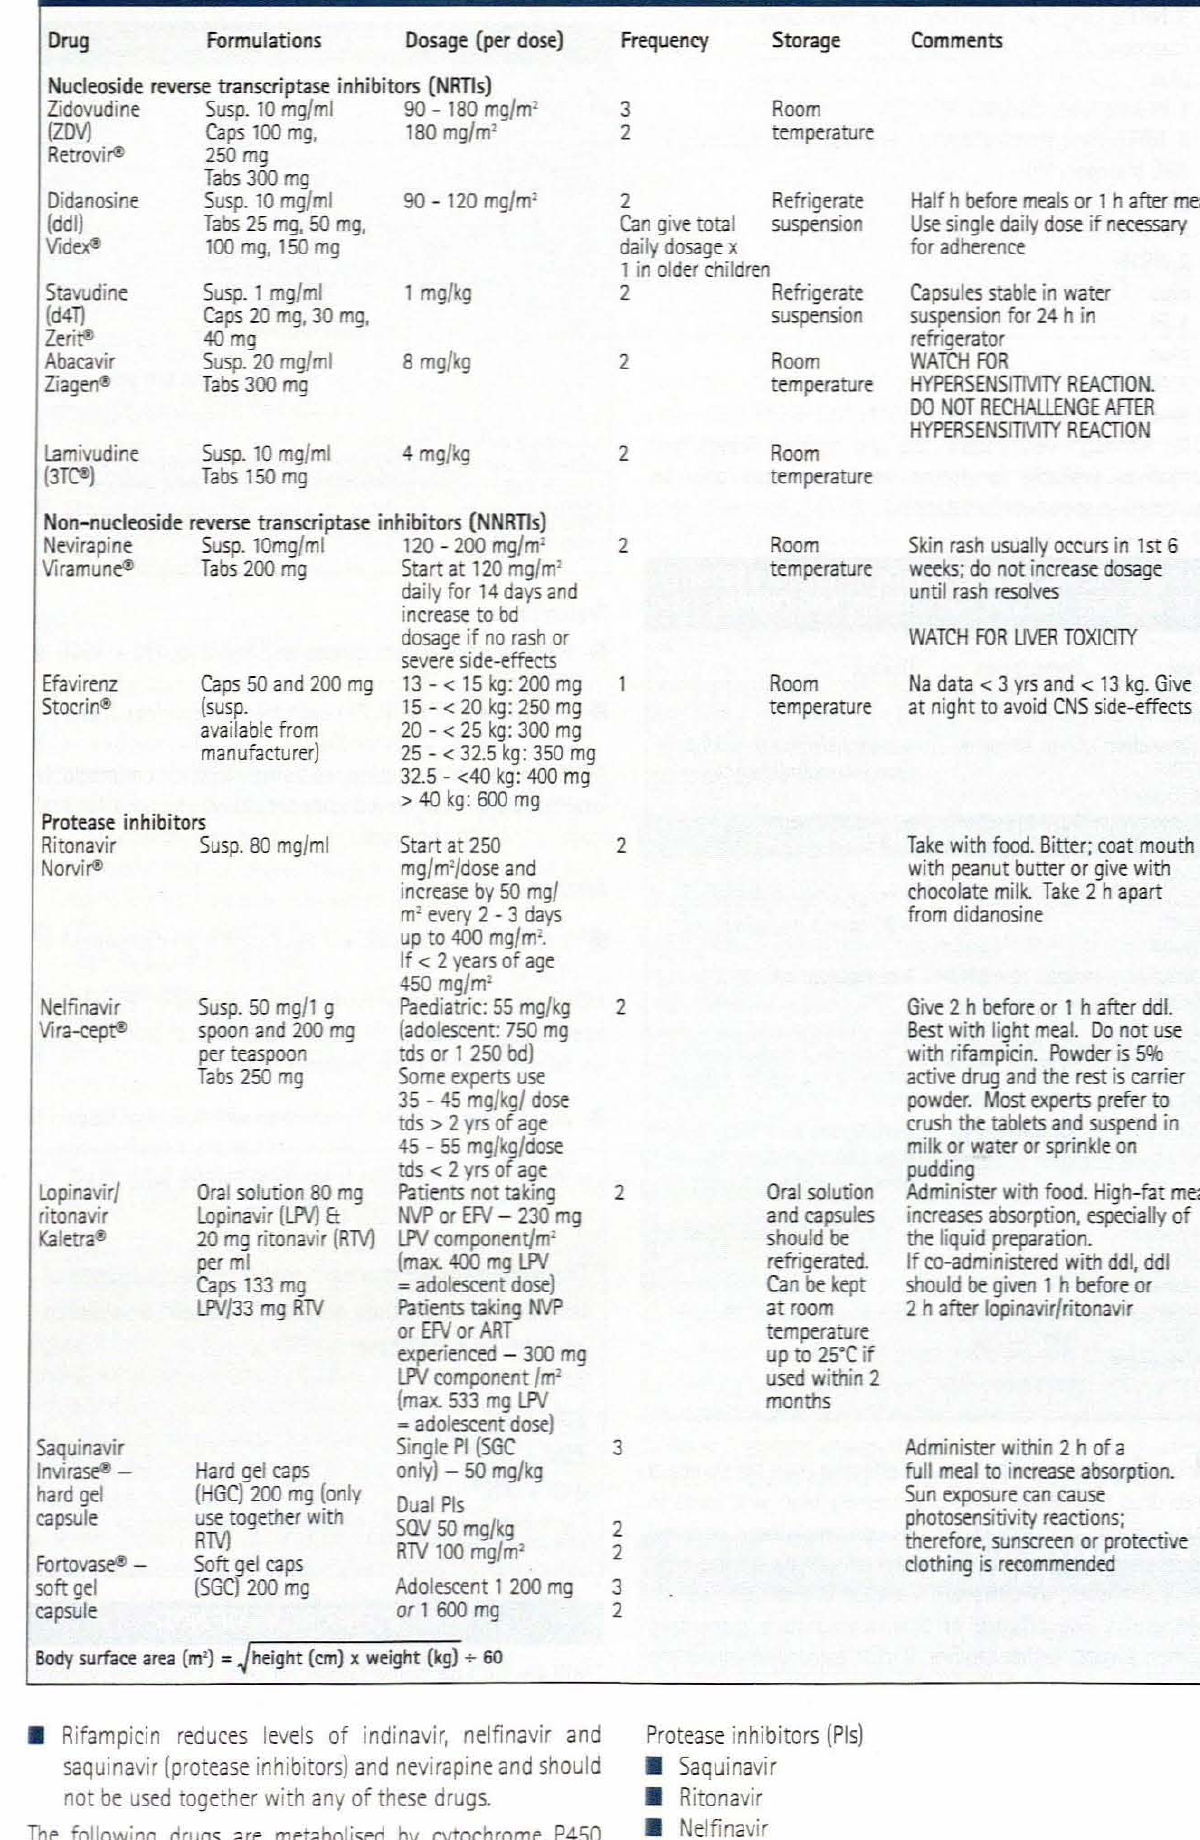
TABLE VII. DOSAGE AND FREQUENCY OF ARVs IN